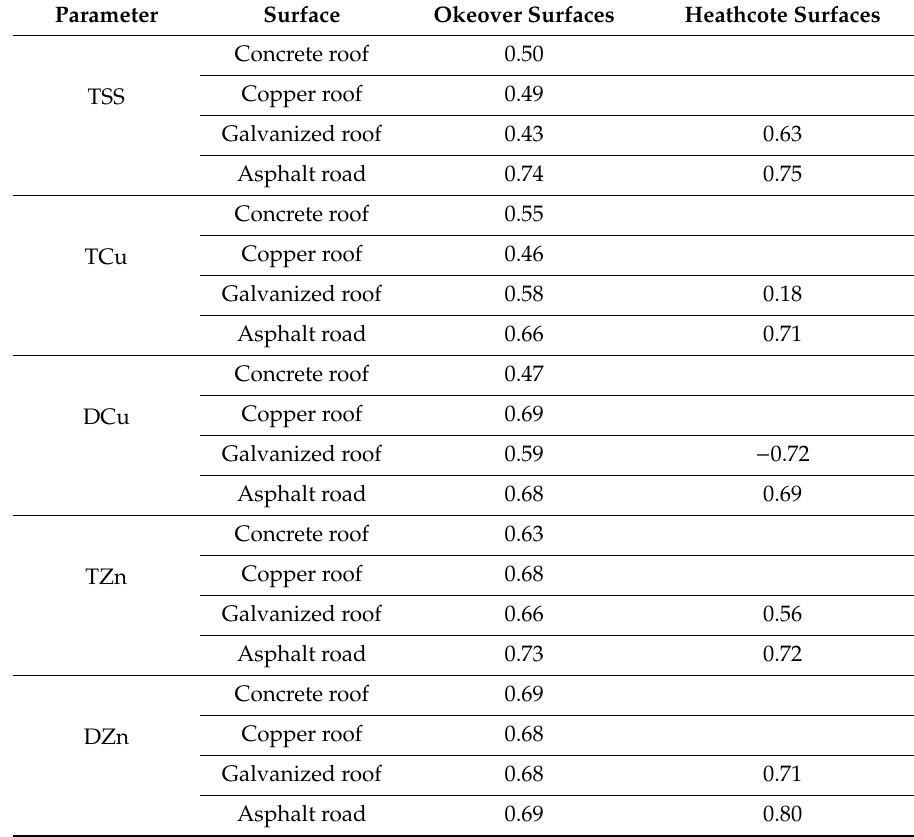
Table 3. Nash–Sutcli ff e model e ffi ciencies (NSEs) of MEDUSA2.0 predicted loads against observed loads for the Okeover surfaces (calibration) and Heathcote surfaces (validation).